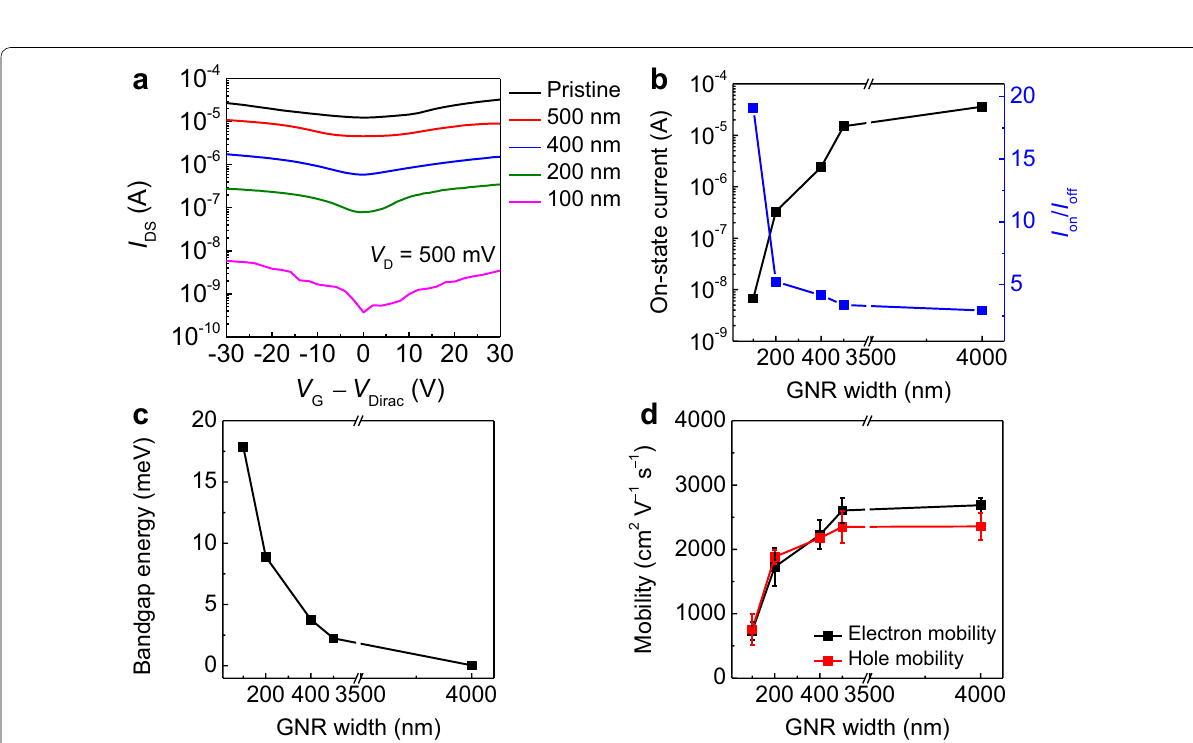
Fig. 5 a I DS – V G characteristics of GNR FETs with various GNR widths. b On‑state current and on/off current ratio, and c bandgap energy of GNR FETs as a function of GNR width. d Electron and hole field‑effect mobilities of GNR FETs as a function of GNR